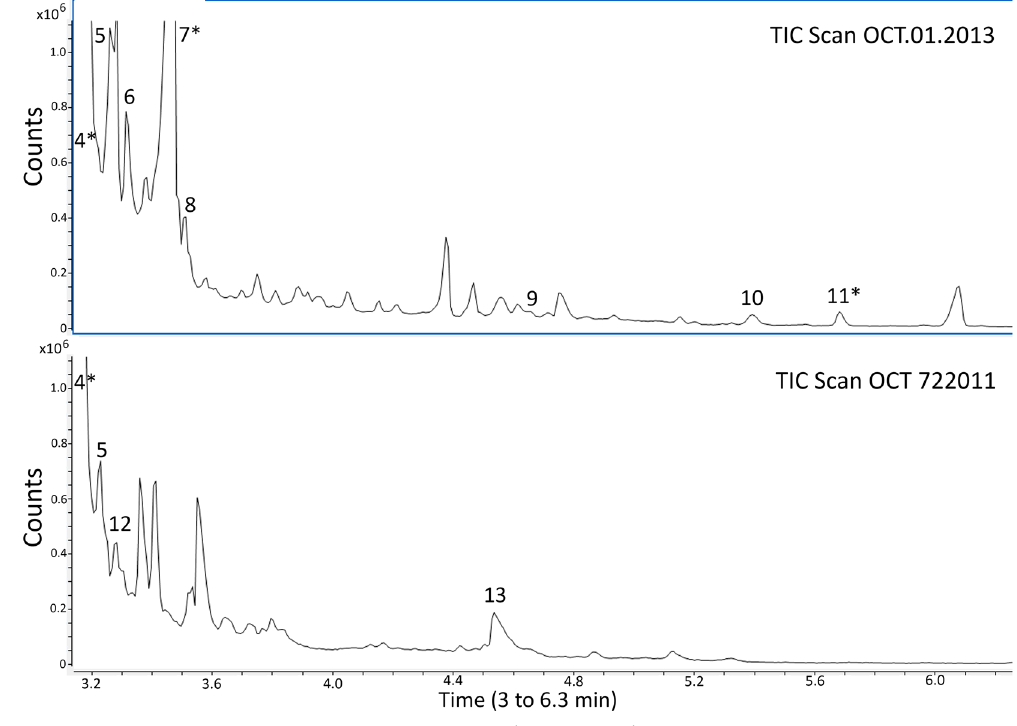
Figure 5. MEROCTANE samples total ion chromatograms (TIC) amplification from 3 to 6.3 min (Agilent Mass Hunter qualitative analysis B.07.00). PFO batch OCT 722011 was distributed and used in Spain, no acute toxic cases were reported. PFO batch OCT.01.2013 was distributed in Chile causing acute toxicity in patients. (4) Perfluorodecalin,